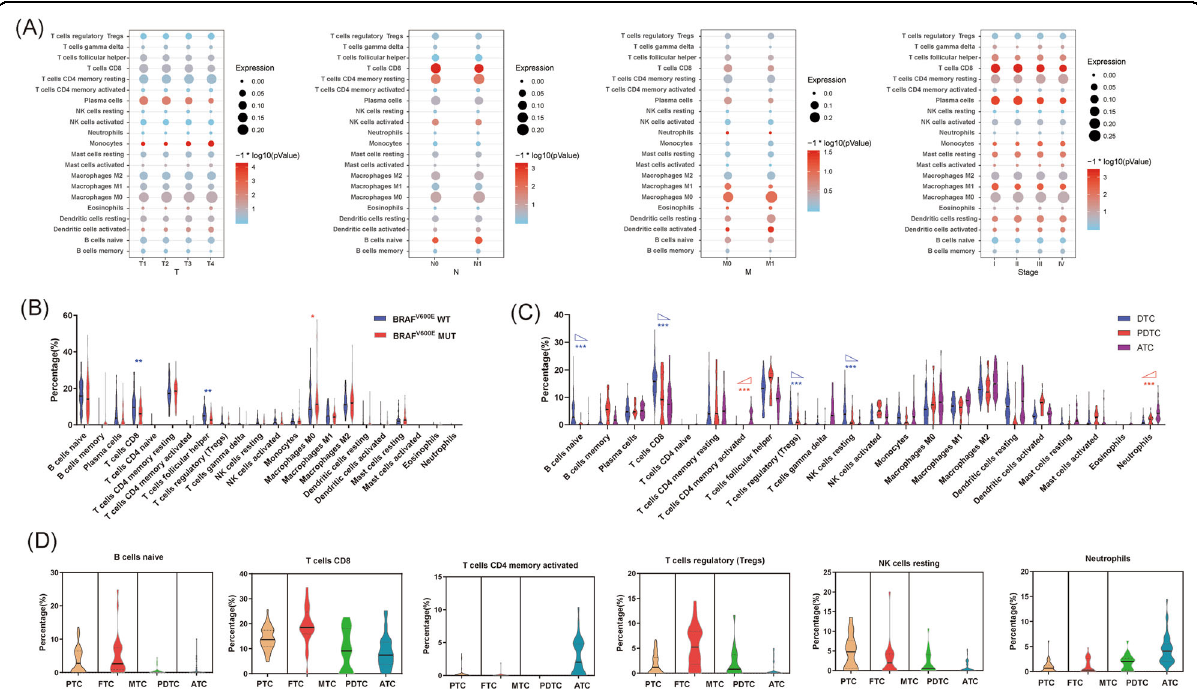
Fig. 2 Immune in fi ltration is associated with different clinical characteristics. A Correlation of immune cells and different pathological stages (pathological TNM stage and pathological stage) of PTC. B Correlation of immune cells and BRAF V600E mutation in PTC. C Correlation between immune cells and different pathological types of thyroid cancer. DTC (differentiated thyroid carcinoma, including PTC and FTC), PDTC (poorly differentiated thyroid carcinoma), ATC (anaplastic thyroid cancer). Red triangle: continual increase; clue triangle: continual decrease. D Correlation of immune cells and speci fi c pathological types of thyroid cancer. (* P < 0.05, *** P <